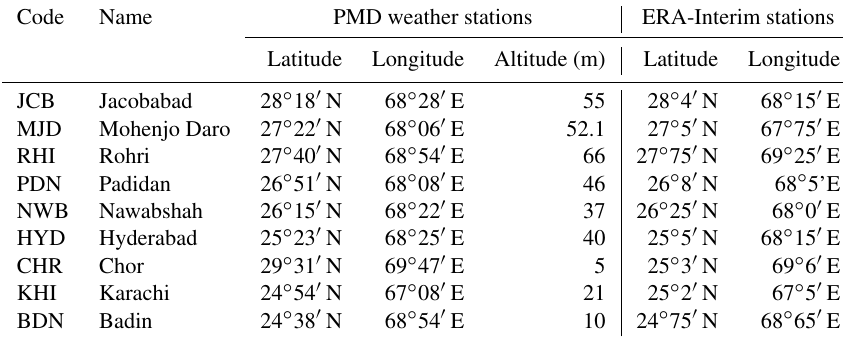
Table 1. Code, name, geographic coordinates, and altitude of the stations. Code